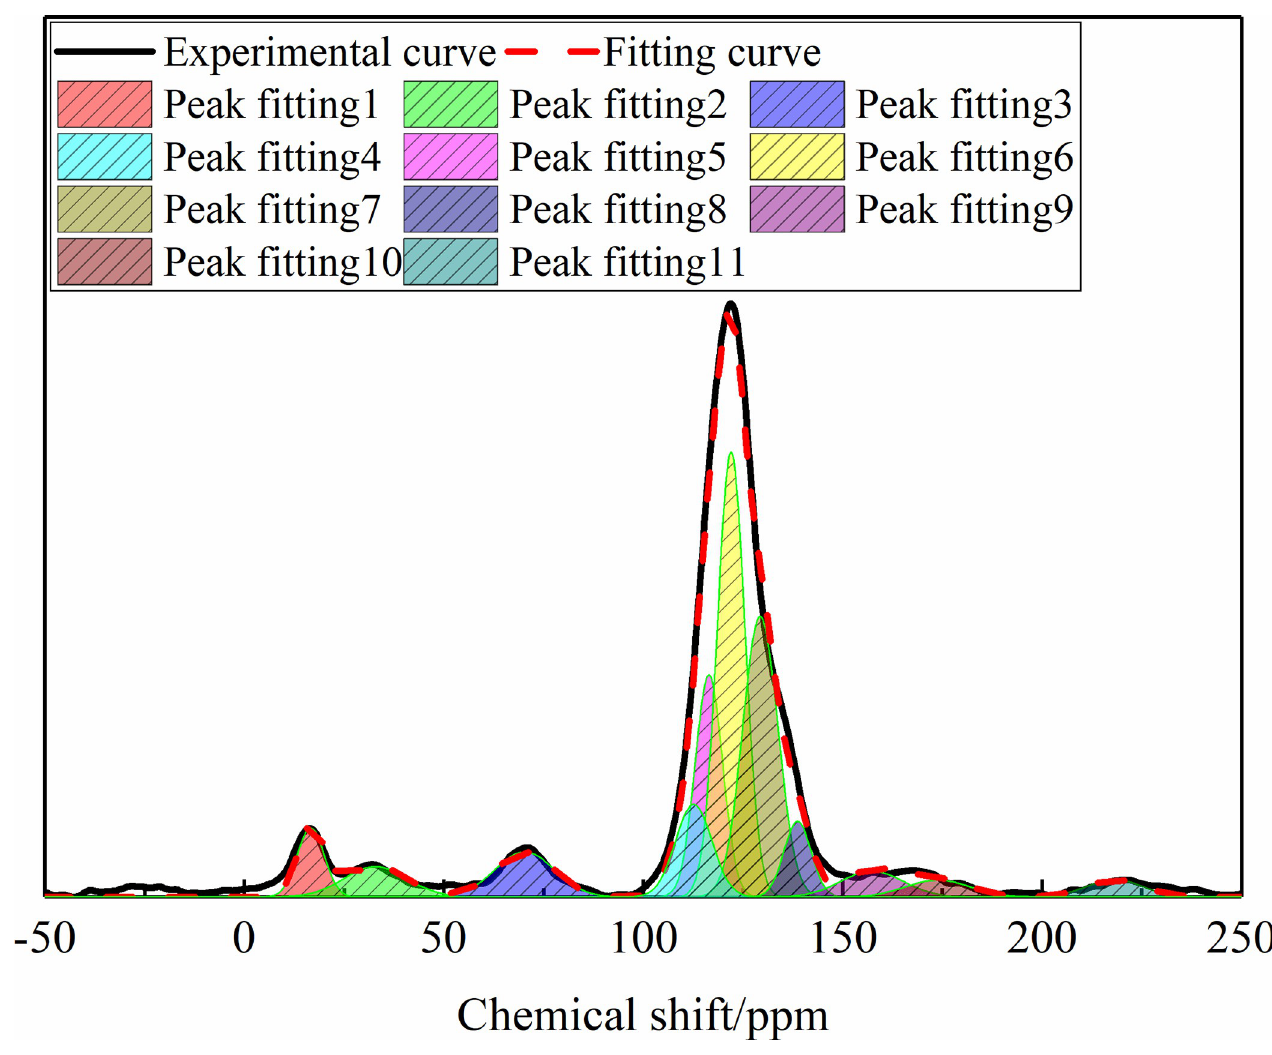
Fig 9. 13C NMR peak fitting spectra of anthracite.